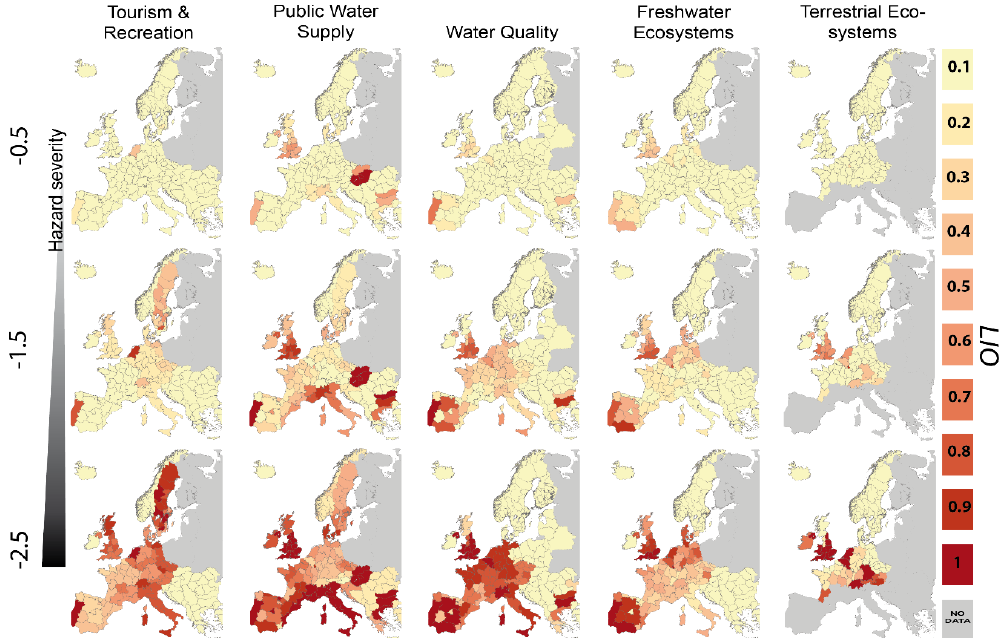
Figure 5. Drought risk maps with the likelihood of impact occurrence (LIO) in the impact categories Tourism and Recreation, Public Water Supply, Water Quality, Freshwater Ecosystems, and Terrestrial Ecosystems (columns) for three hazard levels of SPEI with − 0.5: near normal, − 1.5: severely dry, and − 2.5: extremely dry